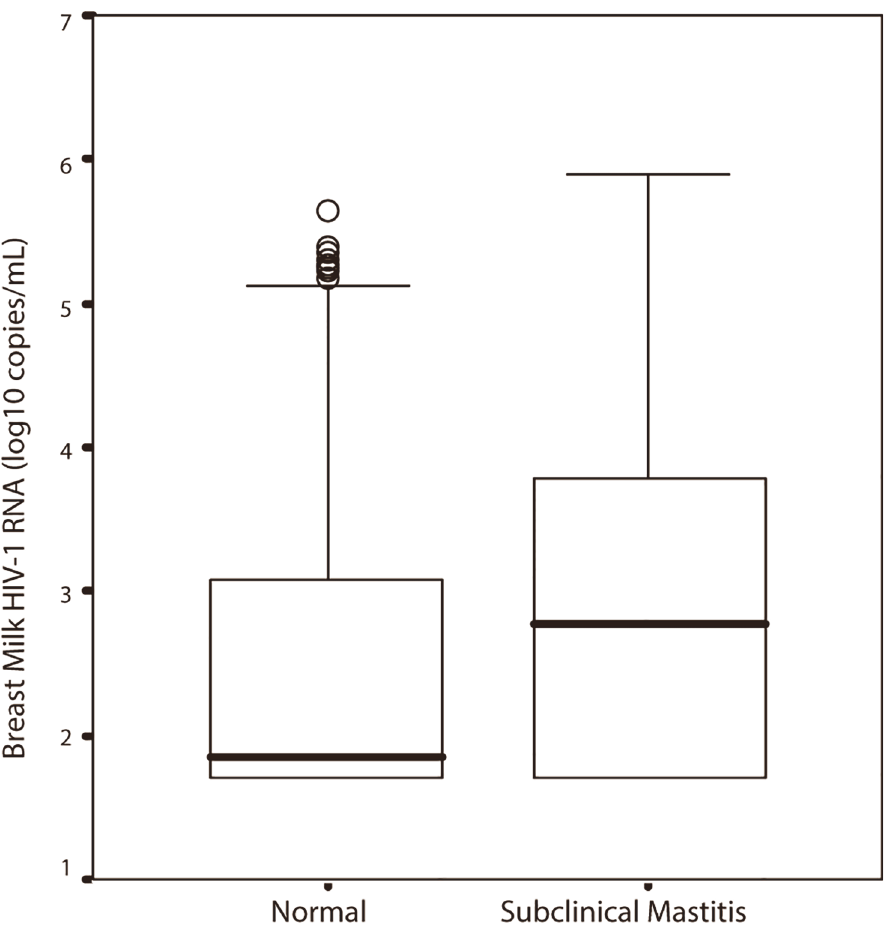
1 RNA and Na + concentrations were used (744 samples with Na + concentration (cid:1) 12 mmol/L and 453 samples with Na + concentration > 12 mmol/L). Box plots display medians, quartiles and